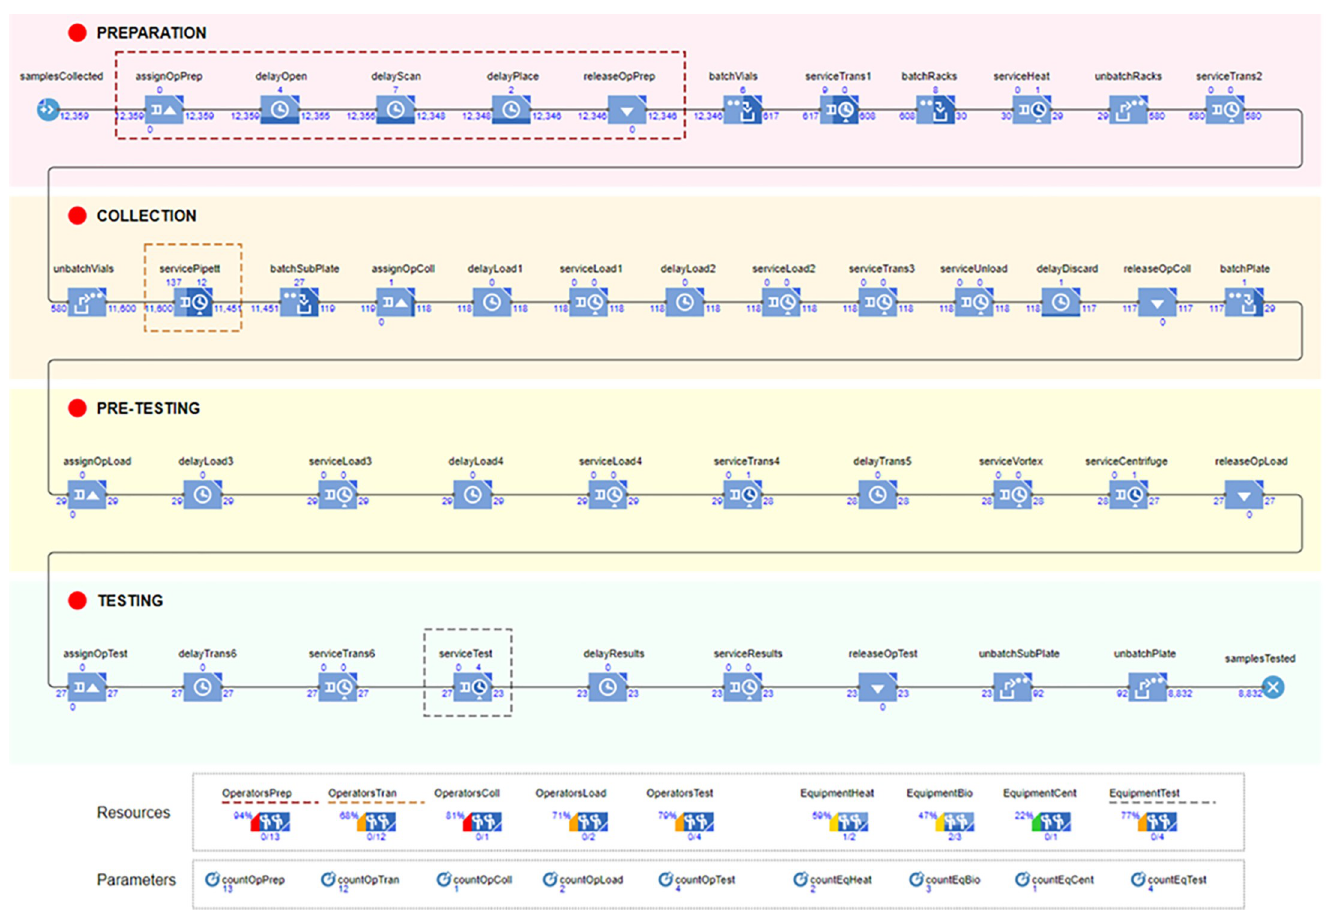
Fig 4. Developed DES model, with pools of resources and parameters to optimize.